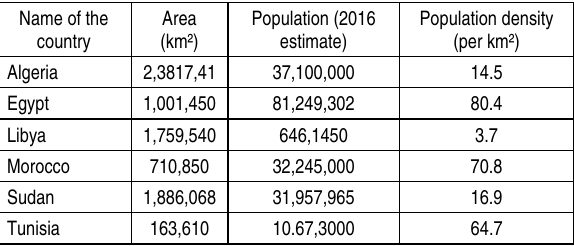
Table 2. The countries of North